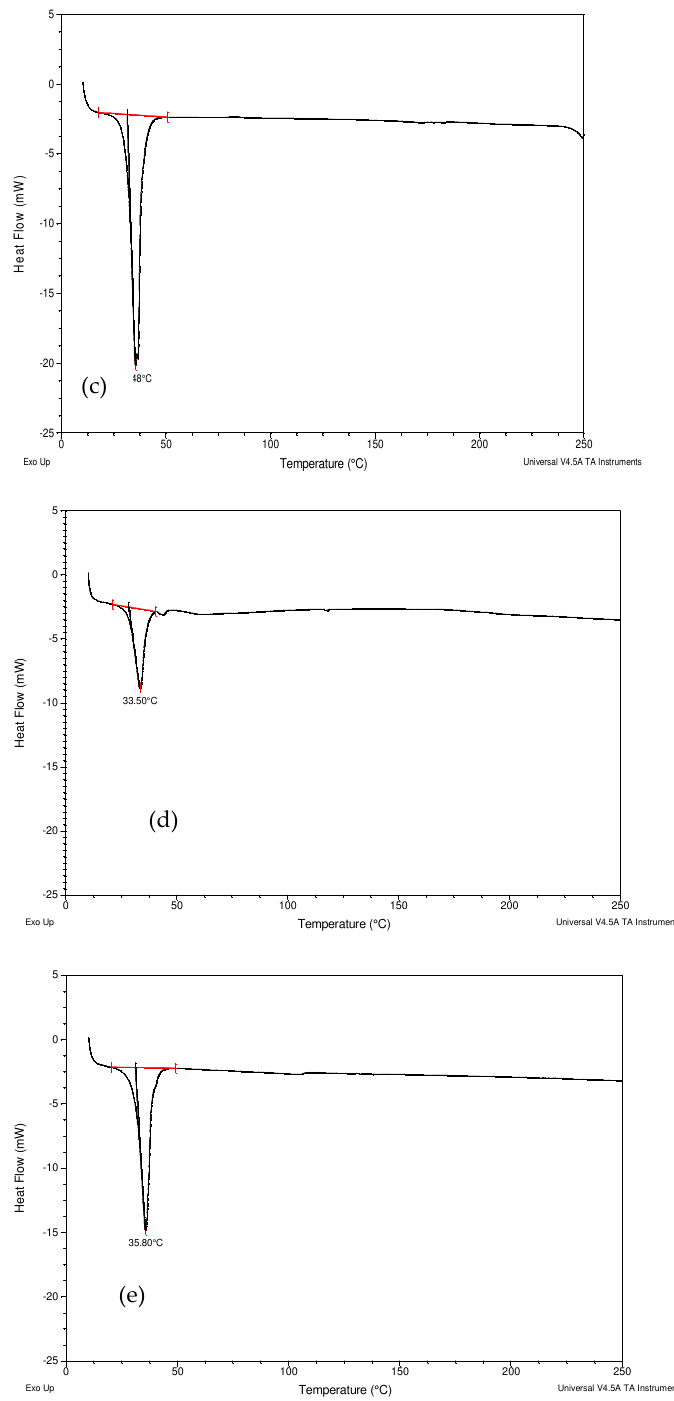
Figure 5. DSC thermograms of ( a ) commercial curcumin, ( b ) Soluplus ® , ( c ) Vitamin E TPGs, ( d ) Formulation A ( e ) the physical mixture of Formulation A (curcumin: Soluplus: Vitamin E TPGs 1:10:10), showing the endothermic peaks.